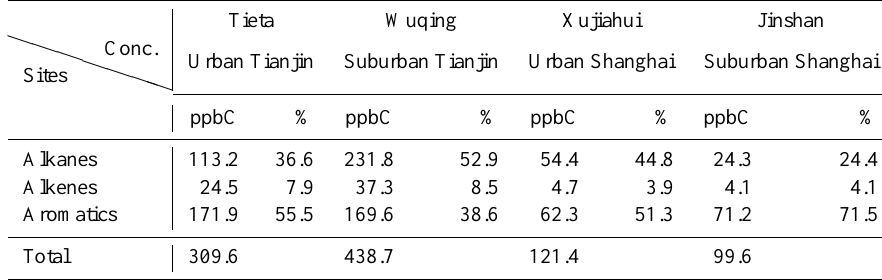
Table 1. Average mixing ratios and fractions of the three NMHC categories at the four sites. Tieta P PP Sites